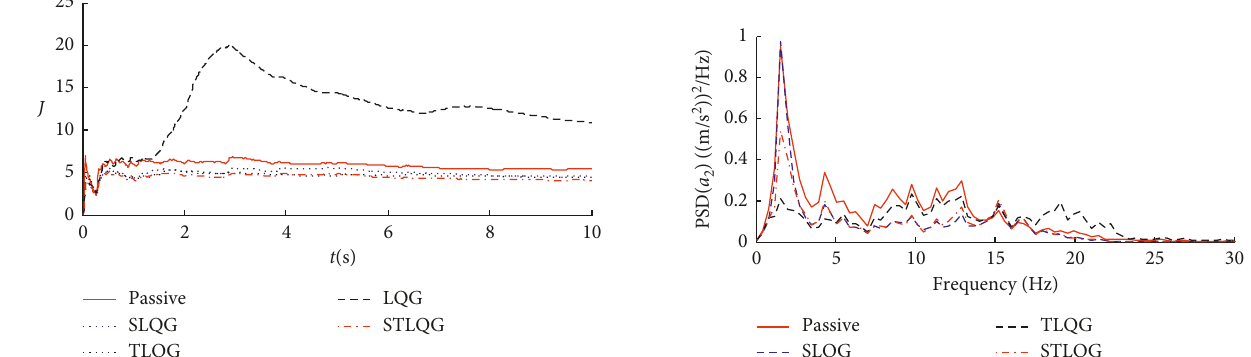
Figure 14: PSD ( a 2 )-frequency curves under 20 ms time delay.